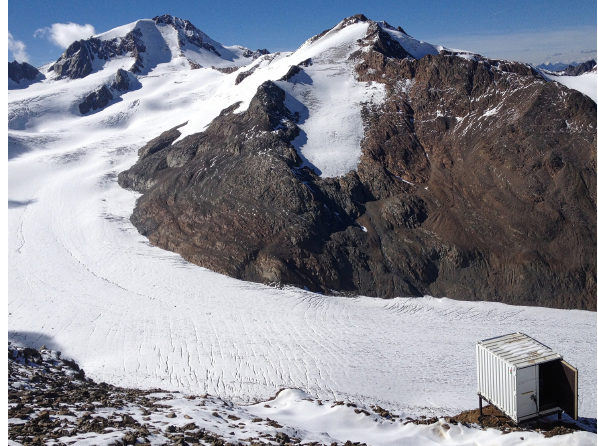
Figure 15. The terrestrial laser scanner in its container housing at Im hintern Eis (3244ma.s.l., 46.79586 ◦ N, 10.78277 ◦ E). View to the west over the upper areas of Hintereisferner to the summit of Weisskugel (3739ma.s.l.) and Langtauferer Spitze (3529ma.s.l.). Photo by Rudolf